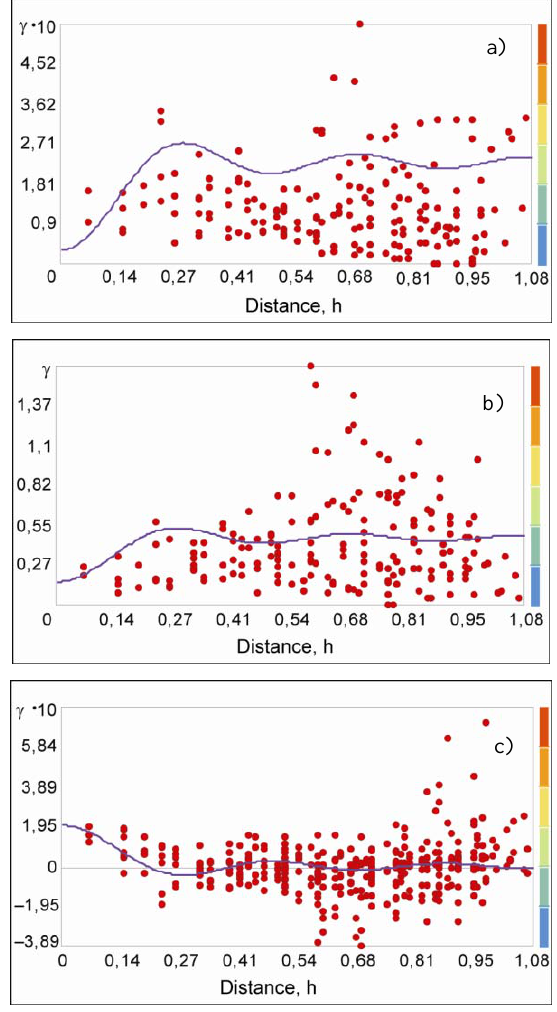
Fig. 3. Omni-directional semi-variograms: a) (Ln)P95; b) (Ln)Altitude, with their cross-covariance model; c) Blue line fits the theoretic model. Distance in degrees (1º= 87.2 km)